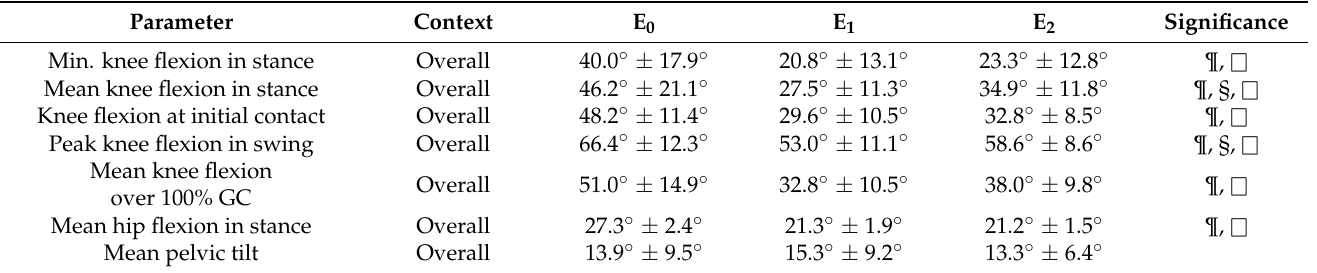
Table 3. Overview of the kinematic parameters at the different time points of patients with repeated postoperative gait analysis (n = 15; 22